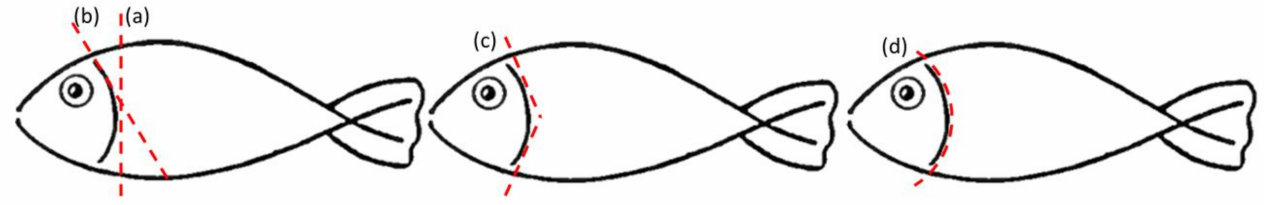
Figure 1. Schematic illustration of fish de-heading position: ( a ) Straight cutting, ( b ) Slant cutting, ( c ) V-cutting, and ( d ) Round cutting along the gill